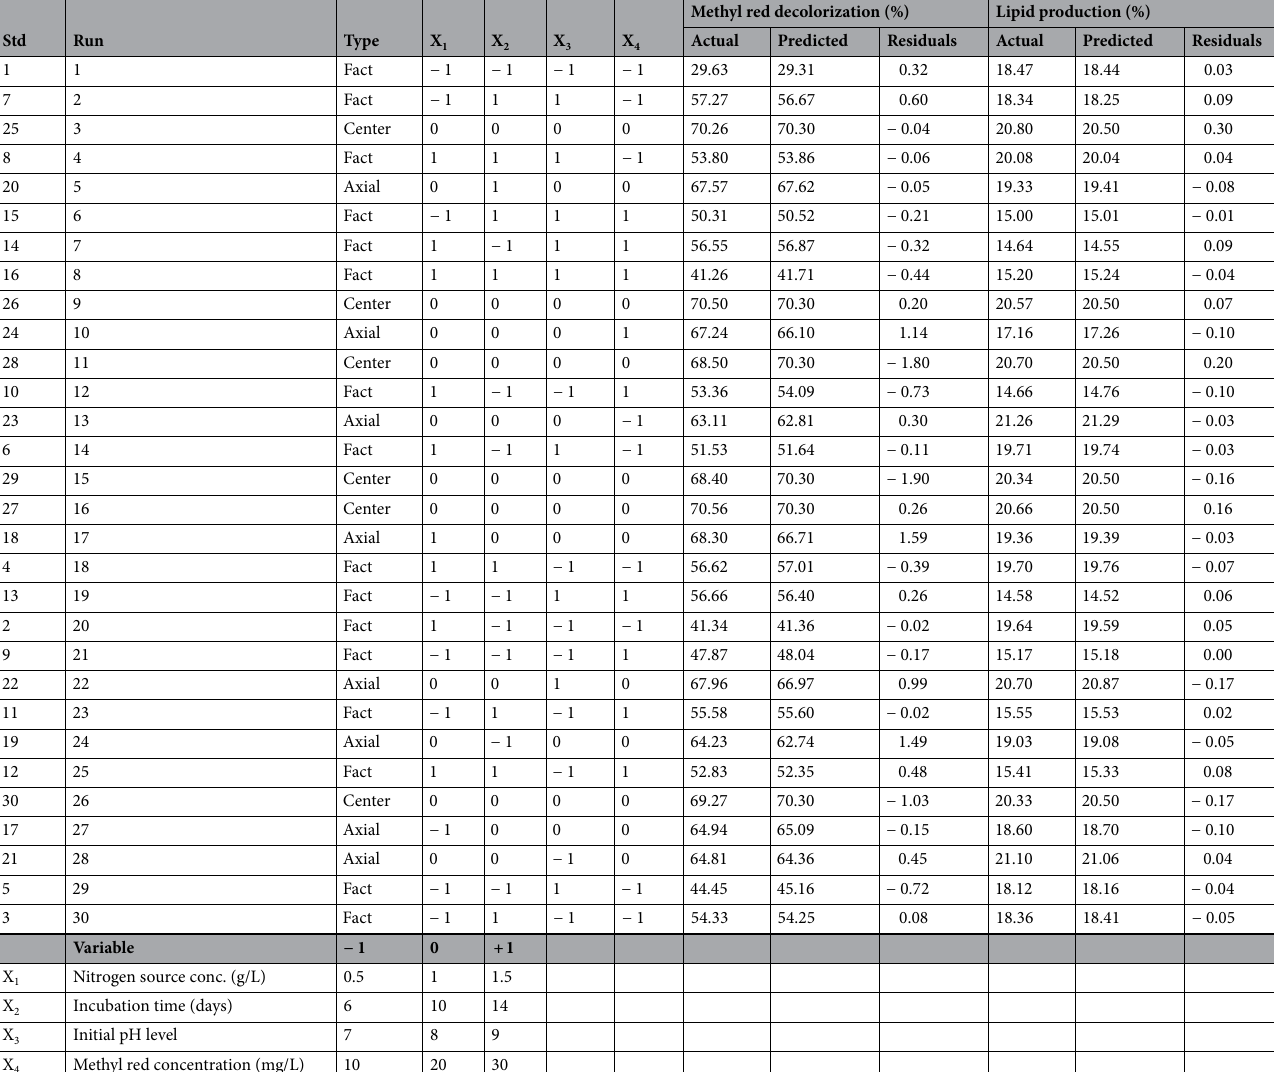
Table 1. Face-centered central composite design matrix of four process variables for methyl red decolorization (%) and lipid production (%) by using Scenedesmus obliquus